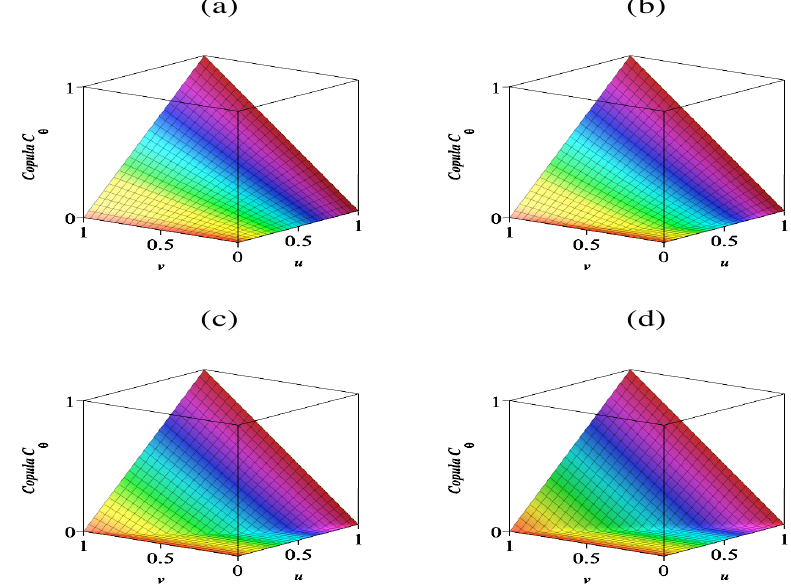
Figure 3. Copulas C θ for ( a ) θ = 0.2, ( b ) θ = 0.5, ( c ) θ = 0.75 and ( d ) θ =